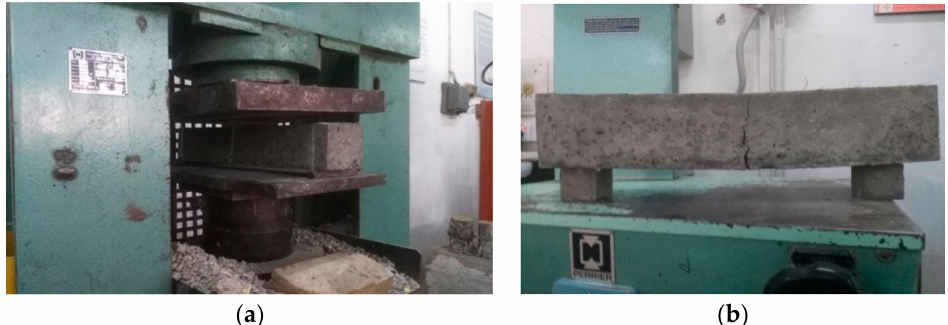
Figure 9. ( a ) Flexural testing setup for Prismatic specimens of length 500 mm; and ( b ) the failure of a specimen after the test.